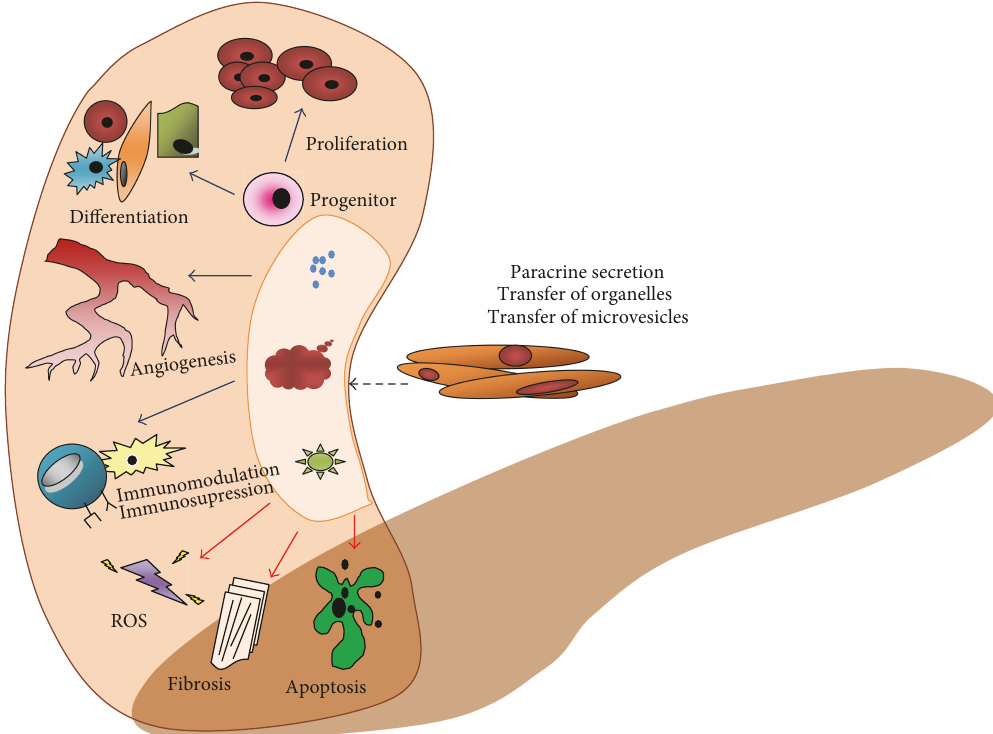
Figure 3: Mechanisms of the protective e ff ect of MSC in the process of acute kidney injury (ROS =reactive oxygen species; blue arrow=process activation; red arrow=process inhibition) (adapted from